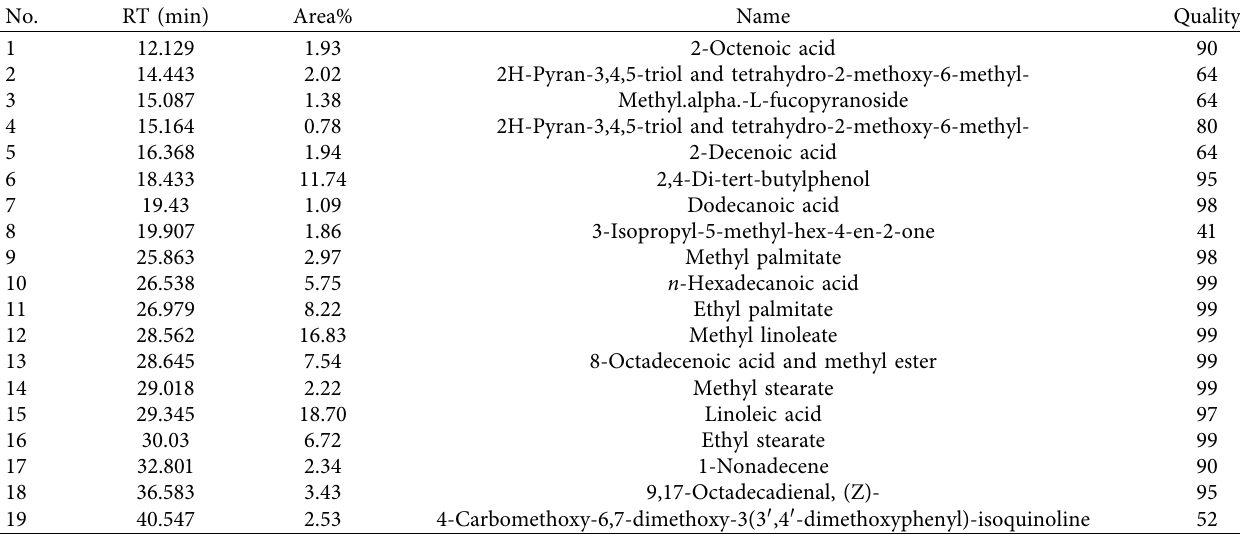
Table 4: Te chemical composition of the partially purifed biosurfactant produced by P. guguanensis strain Iraqi ZG.K.M and analyzed by